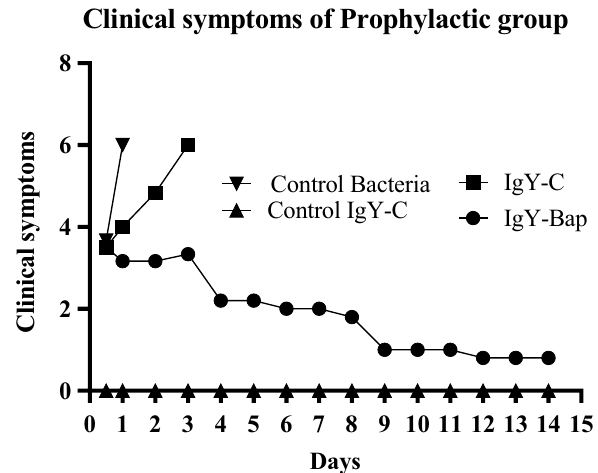
Figure 6. Clinical symptoms of mice for 14 days after challenge. Control: The group without any treatment before infection. IgY-C: the group receiving control IgY 1 h before inoculation. IgY-Bap: the group receiving IgY-Bap antibody 1 h before inoculation. Control Igy-C: the group receiving only the control IgY-C antibody. No clinical sign was seen in the control IgY-C group. In the IgY-Bap group, the mean clinical symptoms after 72 h showed a descending trend compared to the IgY-C and bacterial groups. The recovery process began with the reduction of the severity of